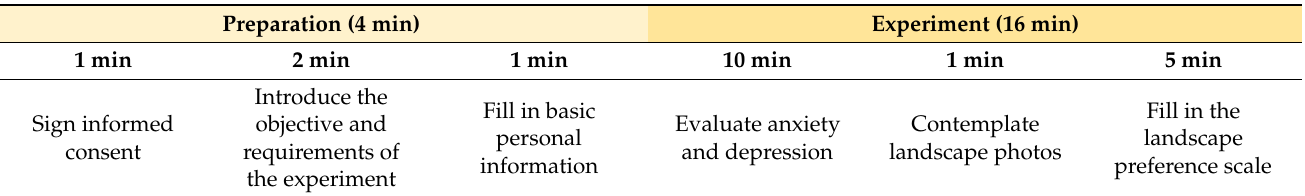
Table 1. Procedure of study A. (The procedure includes two stages: The first stage is for preparation; the second stage is experiment conduction. The whole process needs 20